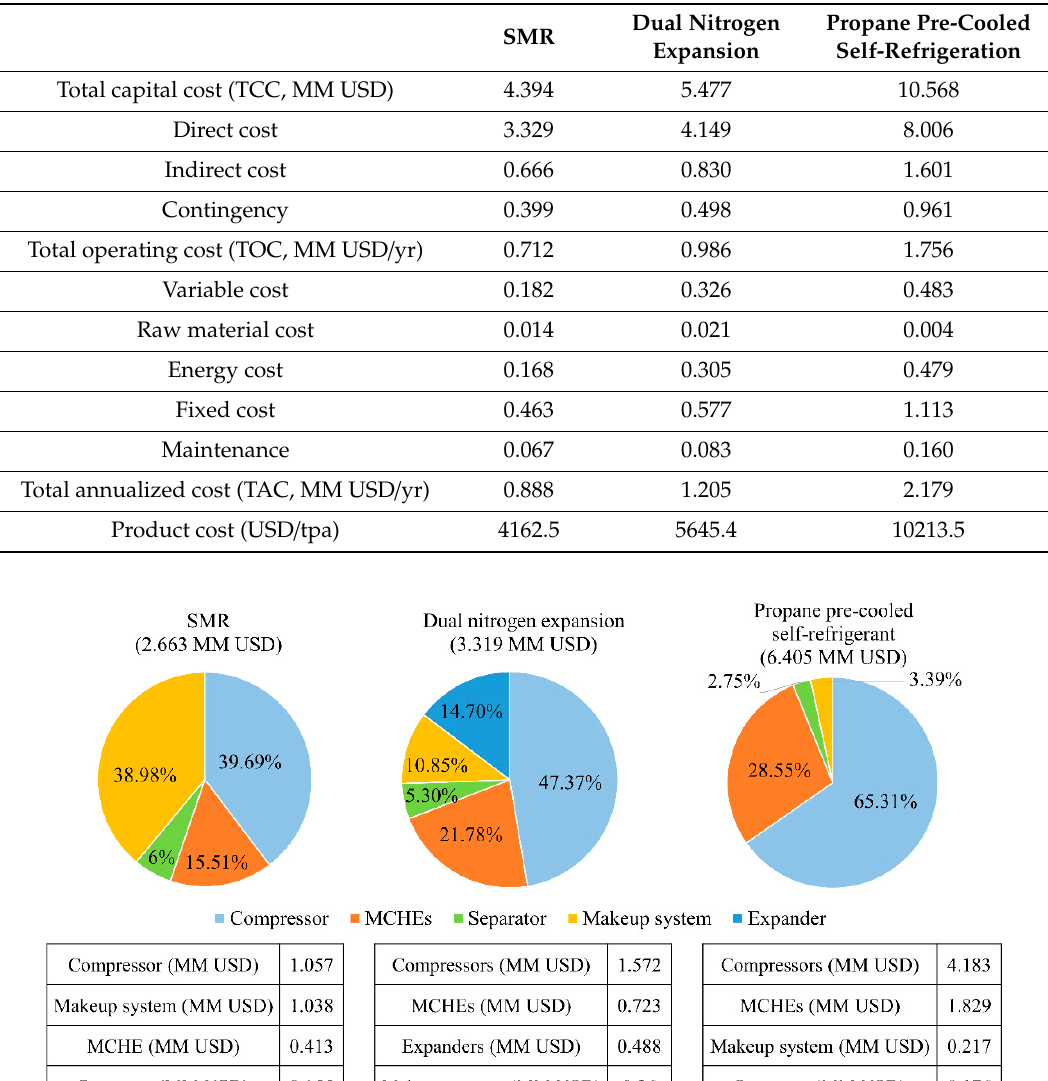
Table 6. Summary of the cost analysis results.